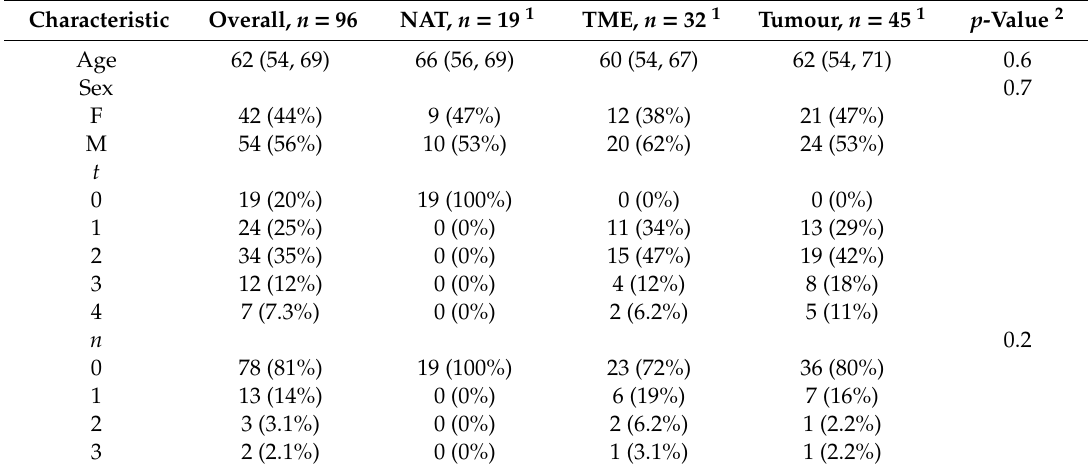
Table 2. Patient characteristics of the TMA cohort by DSP tissue